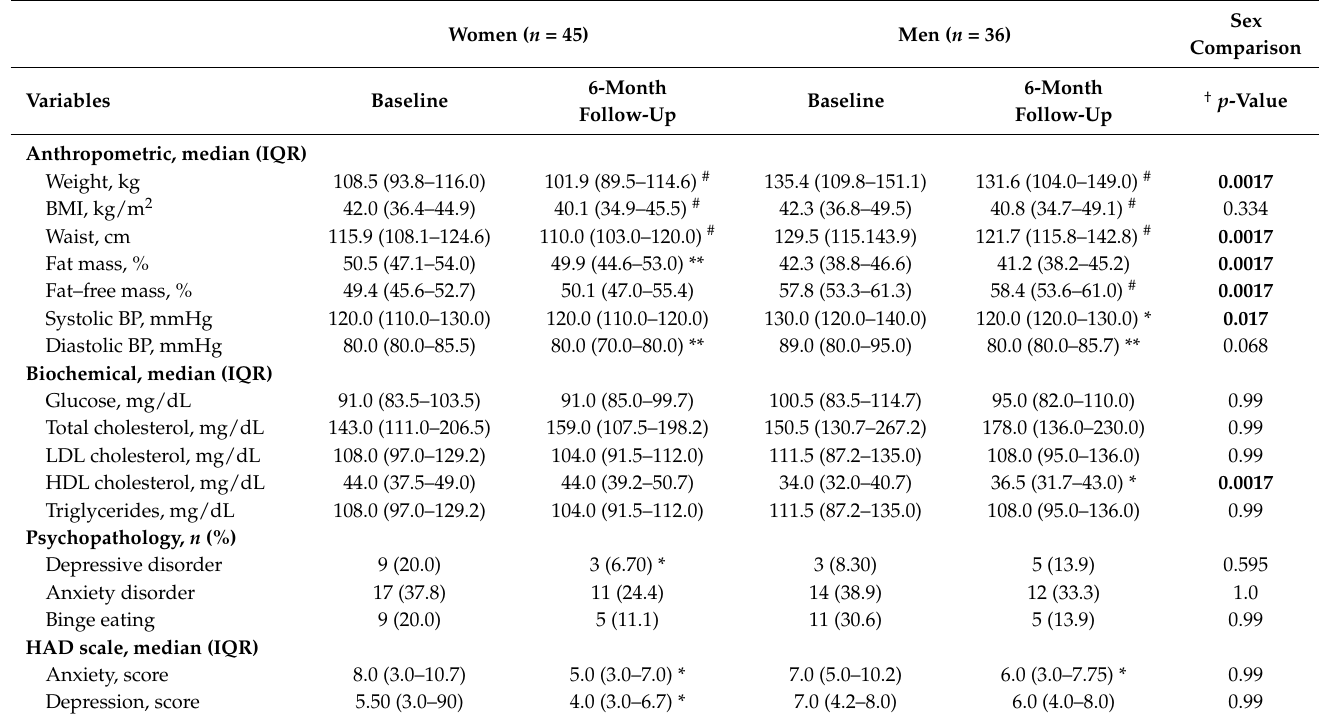
Table 2. Comparison of anthropometric, biochemical, and psychopathology parameters after six months of a multidisciplinary weight loss program.